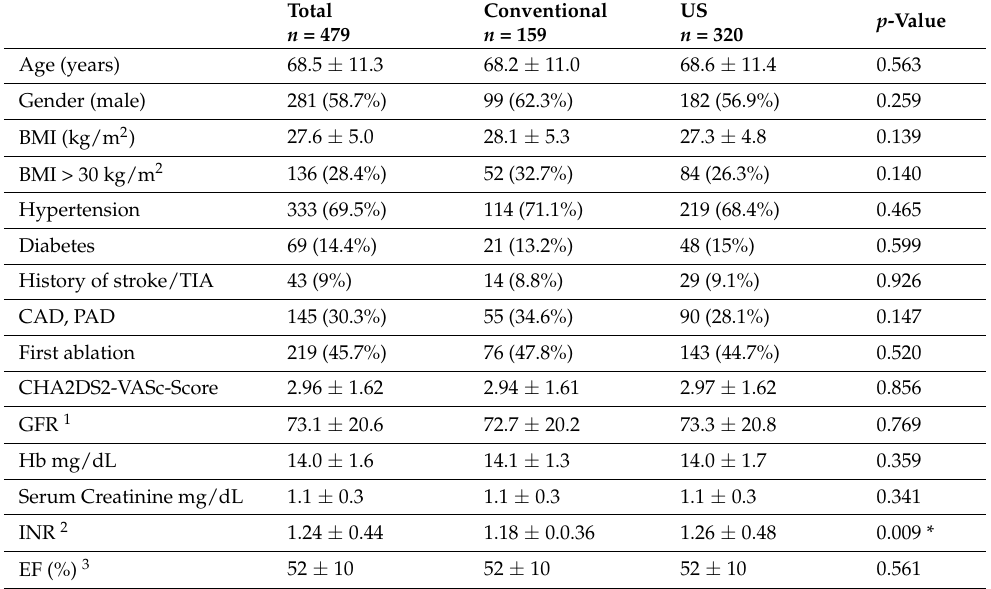
Table 1. Baseline characteristics.